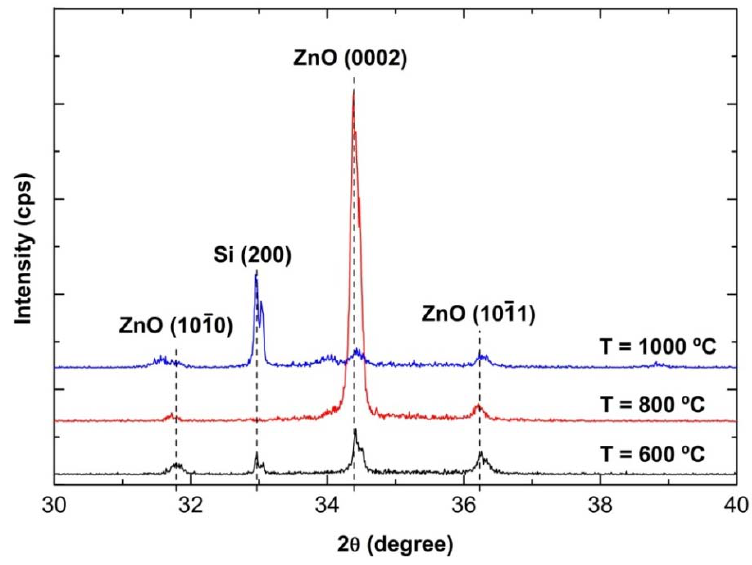
Figure 5. X-ray diffraction (XRD) spectra of ZnO nanorods grown on PS substrates at different growth